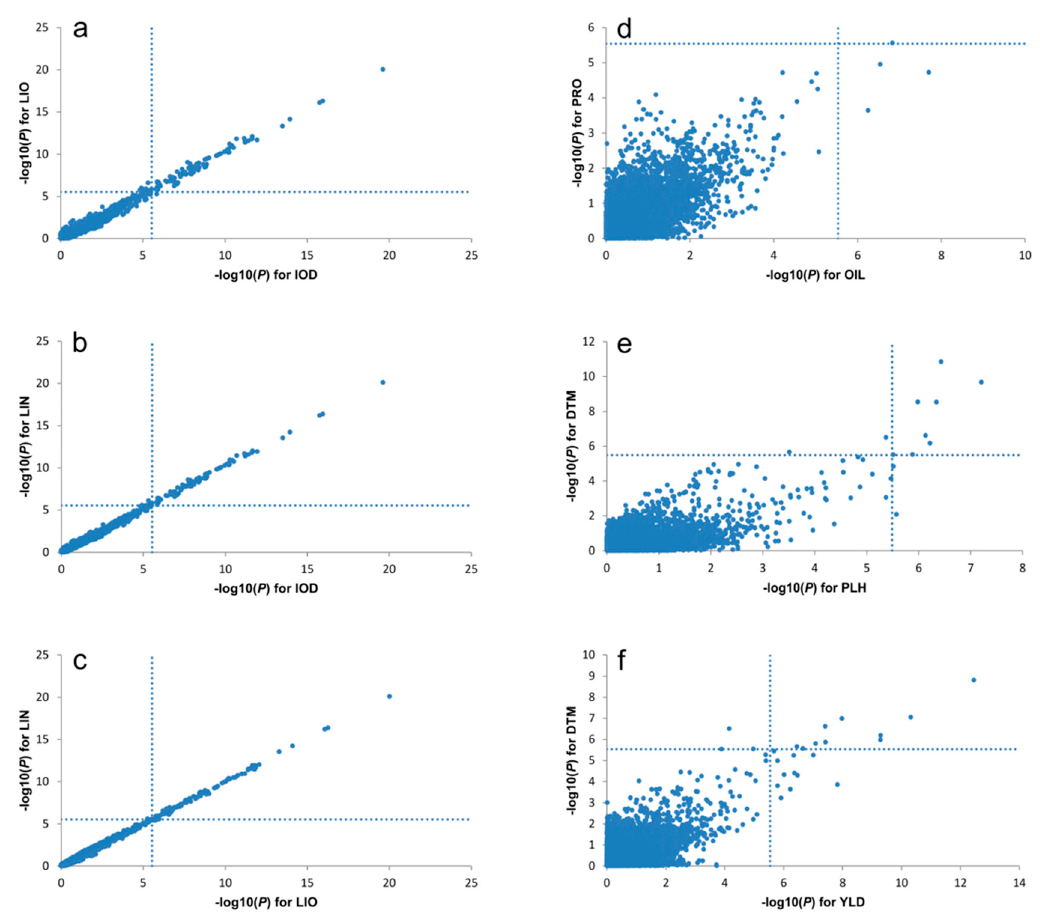
Figure 6. Relations of − log 10 ( P ) values of SNP markers between two traits showing pleiotropy or linkage relationship of SNP markers in different pairs of traits. ( a ) IOD vs. LIN; ( b ) IOD vs. LIO; ( c ) LIN vs. LIO; ( d ) OIL vs. PRO; ( e ) PLH vs. DTM; ( f ) DTM vs. YLD. Results of the GWAS using a GLM and data from the BM + EV + SU population for IOD, LIO, and LIN ( a – c ), the EV population for OIL and PRO ( d ), the BM population for PLH and DTM ( e ) and the BM + EV + SU population for DTM and YLD ( f ) are shown. The vertical and horizontal dashed lines show the cut-off value of significant SNP markers associated with a trait. YLD: seed yield (t ha − 1 ); DTM: days to maturity; OIL: oil content (%); PRO: protein content (%); IOD: iodine value; LIO: linoleic acid content (%); LIN: linolenic acid content (%).